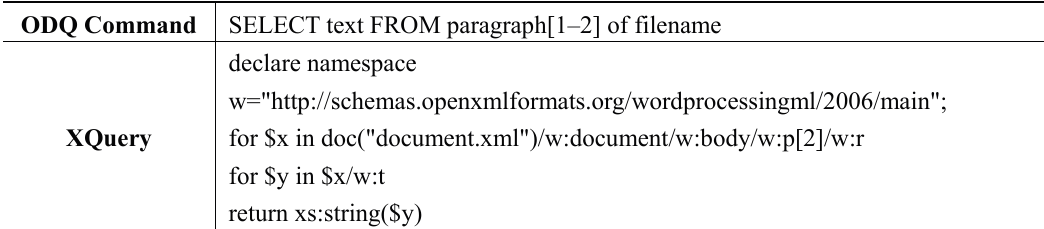
Table 4. Comparison of code to fetch text of the first two paragraphs by ODQ and XQuery. ODQ